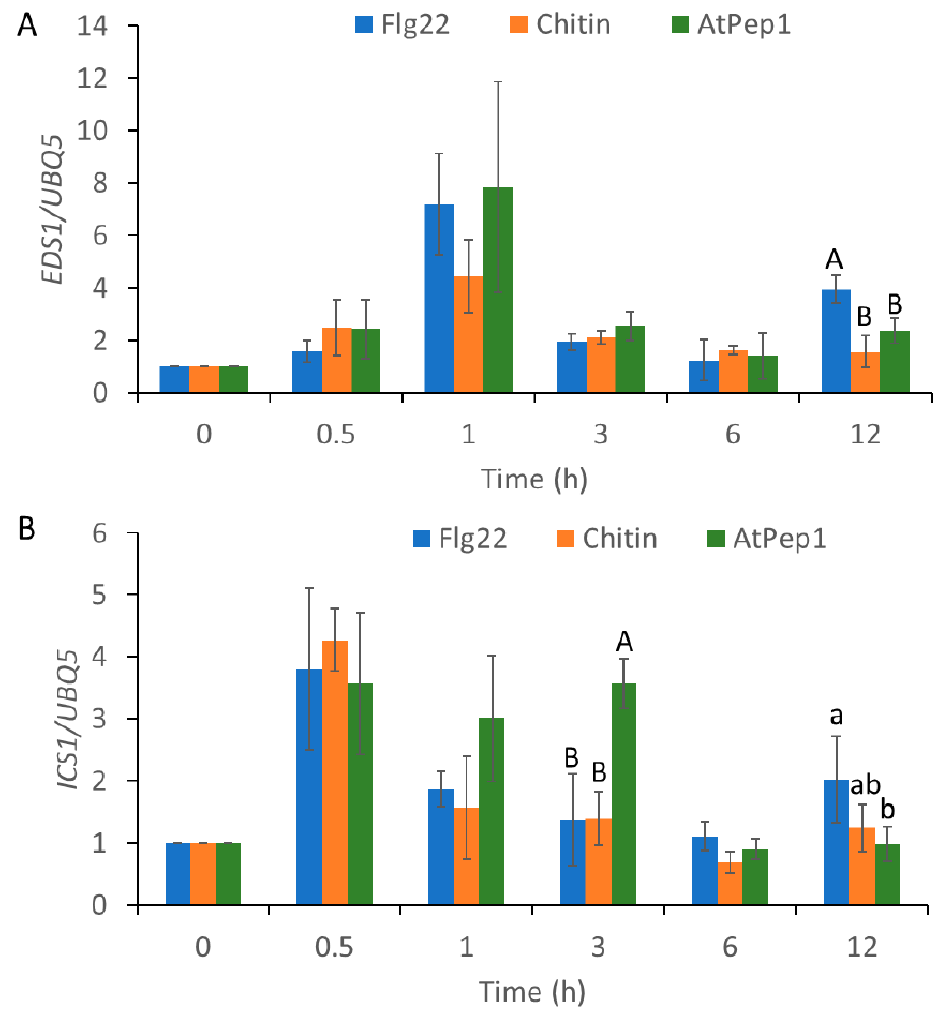
Figure 4. Microbe-associated molecular pattern—(MAMP) and damage-associated molecular pattern (DAMP)-induced transcriptional expression of salicylic acid (SA)-related genes, EDS1 and ICS1 . Fold change in EDS1 ( A ) and ICS1 ( B ) transcript expression in wild-type (WT) Arabidopsis in response to 1 µM of flg22, chitin, and AtPep1 at 0, 0.5, 1, 3, 6, and 12 h after the start of treatment. Total RNA samples were prepared from leaves. SA-related gene expression was normalized to that of the UBQ5 gene. Values were means ± SD of three biological replicates. Different letters indicate statistically significant differences among treatments analyzed by one-way analysis of variance (ANOVA) ( p < 0.05) with Tukey test. 3. Discussion In this study, we investigated the relationships between molecular pattern-induced specific Ca 2+ signatures and transcriptional reprograming of defense-related genes as evidenced by the downstream immune responses after deciphering of the Ca 2+ signatures. This study extends our knowledge about the role of Ca 2+ signal in plant immune response as well as encoding and decoding